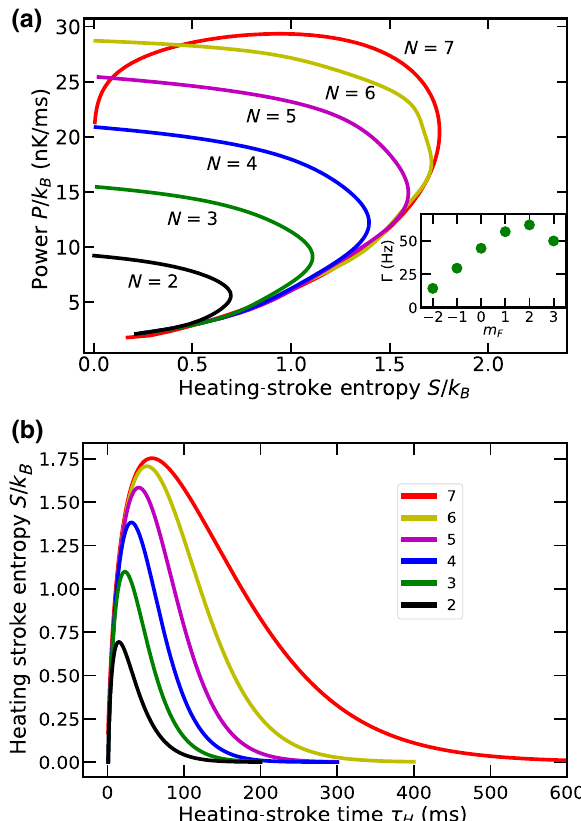
FIG. 5. (a) The evolution of the power output for a truncated working medium with N ≤ 7 levels as a function of the heating- stroke Shannon entropy. The heat exchange rate and cycle time are considered to be the same as for the ( N = 7 ) -level heat engine. The inset shows the rates between two neighboring levels during the heating stroke. The x axis gives the original state, i.e., = 3, up to (cid:7) − 2 →− 3 , located at m = (cid:7) 3 → 2 , located at m F ,Cs F ,Cs − 2. (b) The evolution of the corresponding Shannon entropy as a function of the heating time τ H